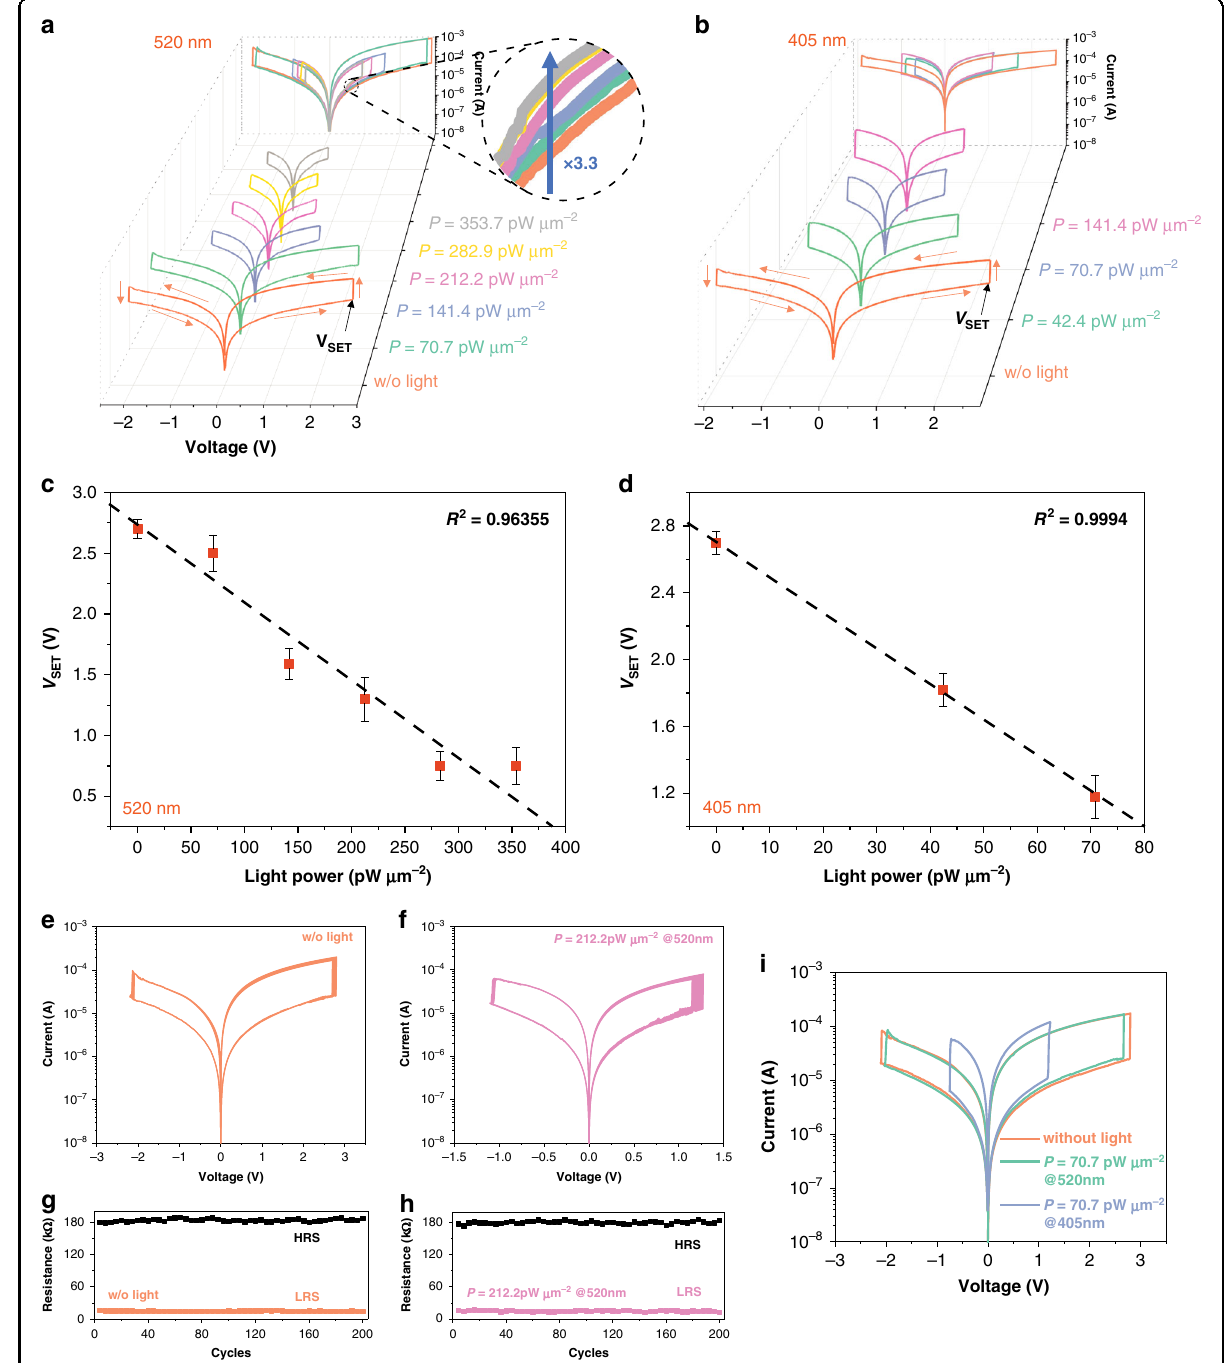
Fig. 2 Electrical characteristic of Opto-Resistive RAM Switch. a , b Current-voltage photoresponse characteristic of Opto-Resistive RAM Switch under a series of illumination from 0 to 353.7 pW· μ m − 2 at the wavelength of ( a ) 520 nm and ( b ) 405 nm, respectively. The inset shows the zoom-in of the I – V curves before resistance switching happens. c , d Mean V SET variation as a function of applied optical power at ( c ) 520 nm and ( d ) 405 nm, respectively. Note that the error bars are the standard error on the mean of 200 cycles. The black dash lines are fi tted straight lines. e I – V characteristic of Opto-Resistive RAM Switch under 200 cycles without input optical signal. f I – V characteristic of Opto-Resistive RAM Switch under 200 cycles with 212.2pW· μ m − 2 optical power at 520 nm. g , h The statistics and distribution of high resistance state and low resistance state over 200 cycles ( g ) without light and ( h ) with 212.2 pW· μ m − 2 optical power at 520 nm. i The I – V photoresponse characteristic of Opto-Resistive RAM Switch under 70.7 pW· μ m − 2 illumination with different input wavelengths. (HRS High Resistance State, LRS Low Resistance